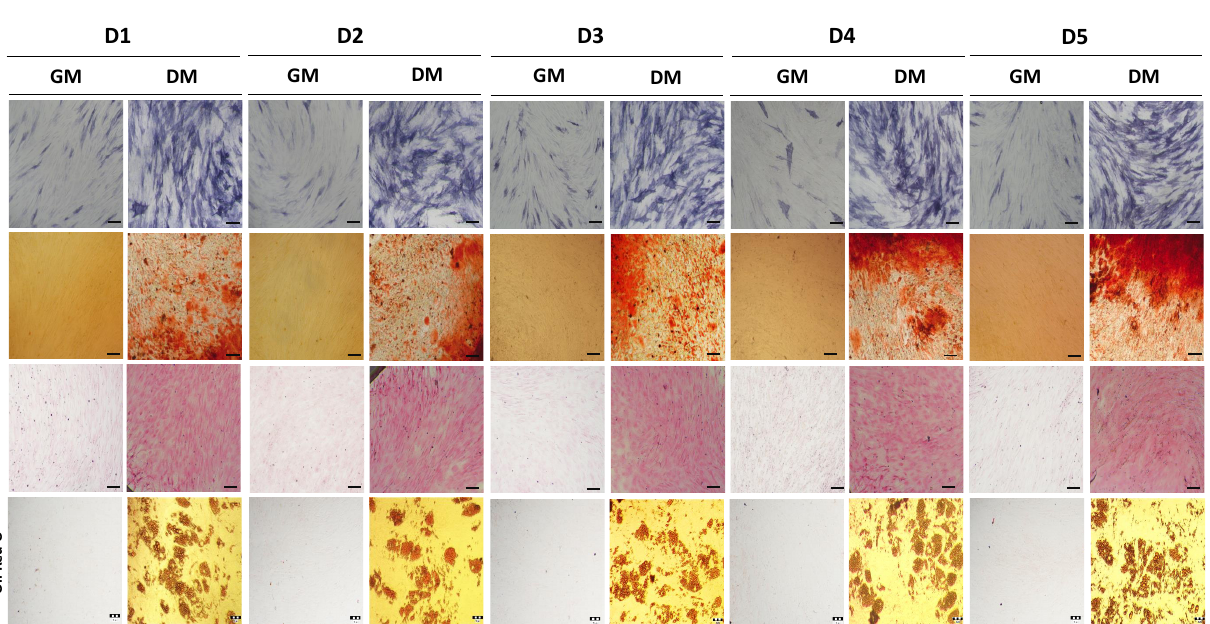
Figure 2. Multilineage differentiation potential of BM-MSCs. Representative images of cells cultivated in GM or differentiation medium (DM) are shown. Osteogenic differentiation detected after 7 days of cultivation by staining for alkaline phosphatase (ALP) activity, and after 21 days for calcium depositions by Alizarin red staining (Scale bar: 50 µ M). Chondrogenic differentiation detected with Safranin O staining of proteoglycans after 21 days cultivation (scale bar: 50 µ M). Adipogenic differentiation determined based on the presence of intracellular lipid droplets by Oil Red O staining after 21 days (scale bar: 20 µ